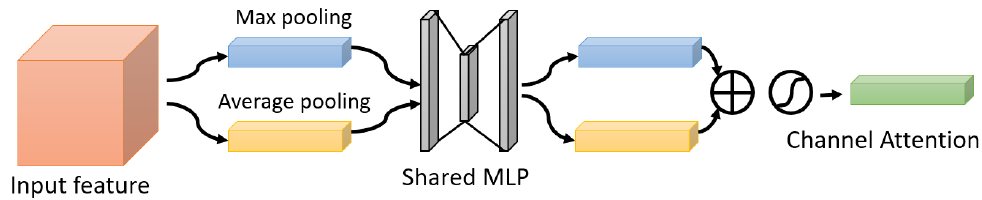
Figure 3. The Channel Attention Submodule.